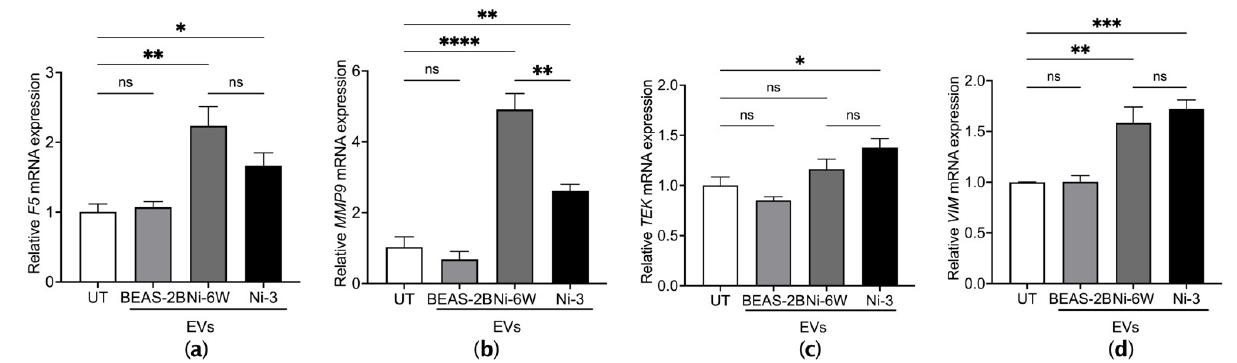
Figure 5. EVs from Ni-exposed BEAS-2B cells altered coagulation and inflammation markers in HUVEC cells. HUVEC cells were treated with 10 µ g/mL of EVs from BEAS-2B, Ni-6W, and Ni-3 cells. The mRNA expression of the coagulation marker ( a ) F5 and inflammation markers ( b ) MMP9, ( c ) TEK, and ( d ) VIM were measured by quantitative real-time PCR. Values are presented as mean ± SEM. ns: no significance, * p < 0.05, ** p < 0.01, *** p < 0.001, and **** p < 0.0001.